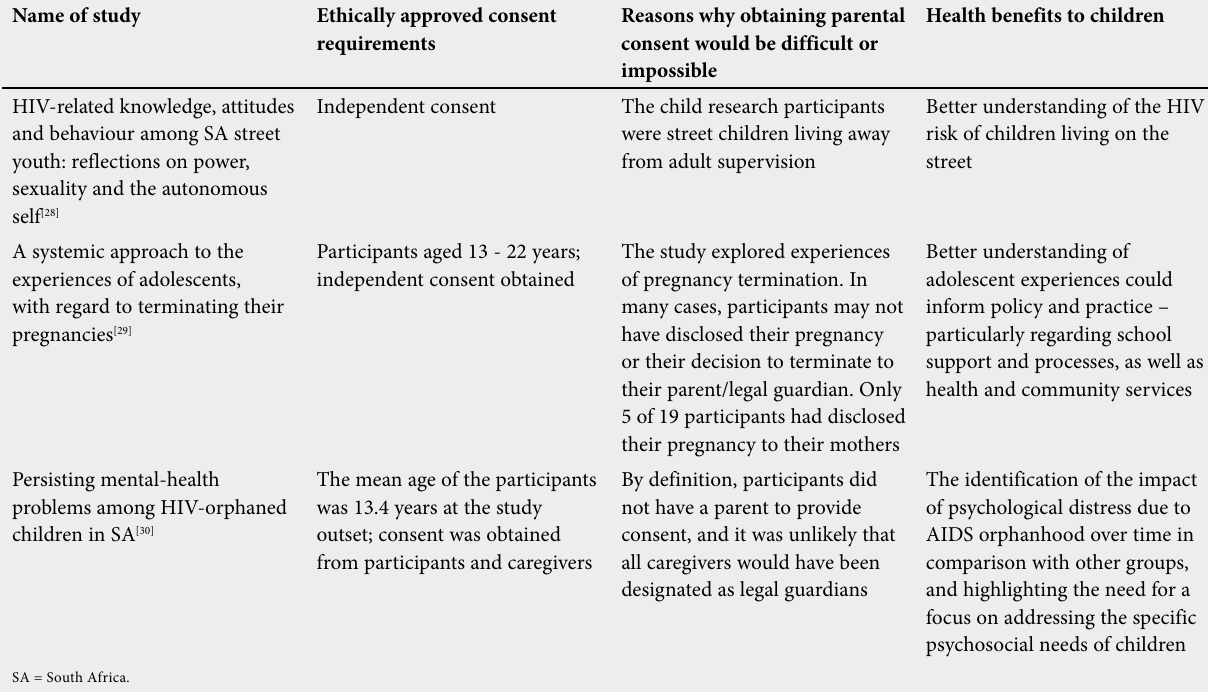
Table 1. Examples of completed studies that would in the future be difficult to undertake with the requirement of parental/legal guardian consent Name of